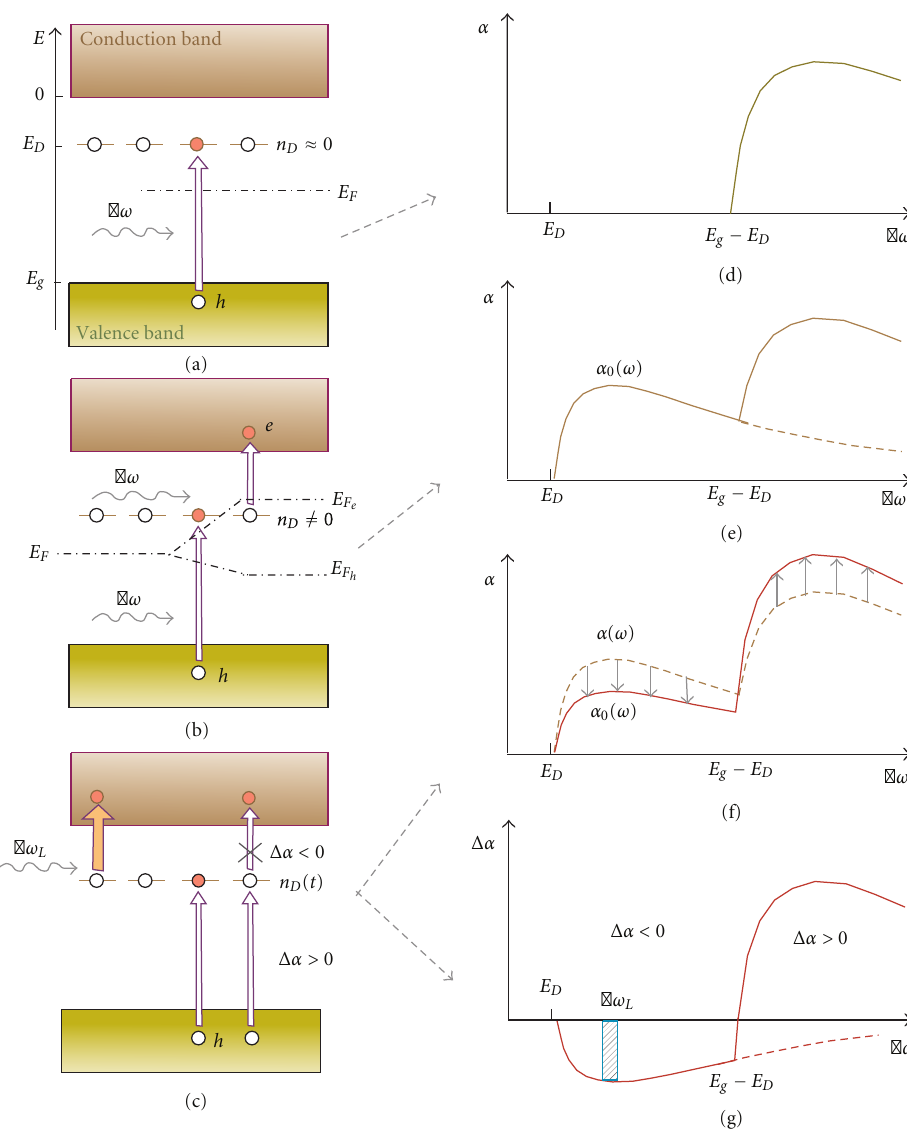
Figure 4: Schemes of stationary α ( ω ) and induced Δ α ( ω ) impurity absorption spectra formation and of the optical transitions, explaining σ -DLSS: regime of laser modulation of TSA by photoionization, at the absence of TPA-generation (2 (cid:2) ω L < E g ). (a) and (d). At small intensity, “dark” filling of the compensated donors, only the band of photoneutralization is observed. (b) and (e) At the intensities of probe light, breaking a dark-filling of DL’s, photoionization band appears. (f) Changes of TSA spectra as a result of laser modulation. (c) and (g) Induced absorption